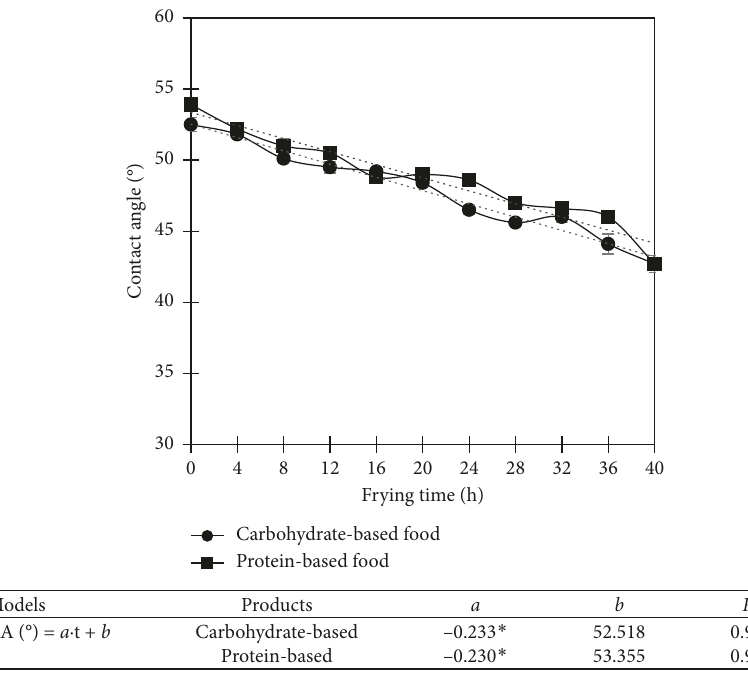
Figure 6: Scatter plots and regression results of contact angle (CA) of frying oil as a function of time ( t